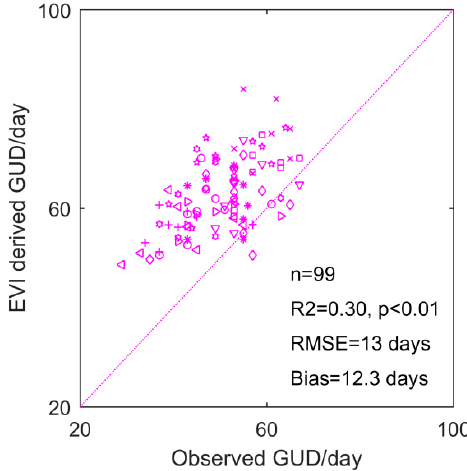
Figure 3. Validation of the satellite-derived GUD in relation to the field-observed GUD. The red dashed line is the 1:1 relationship, and the various symbols represent the eleven agro-meteorological stations.